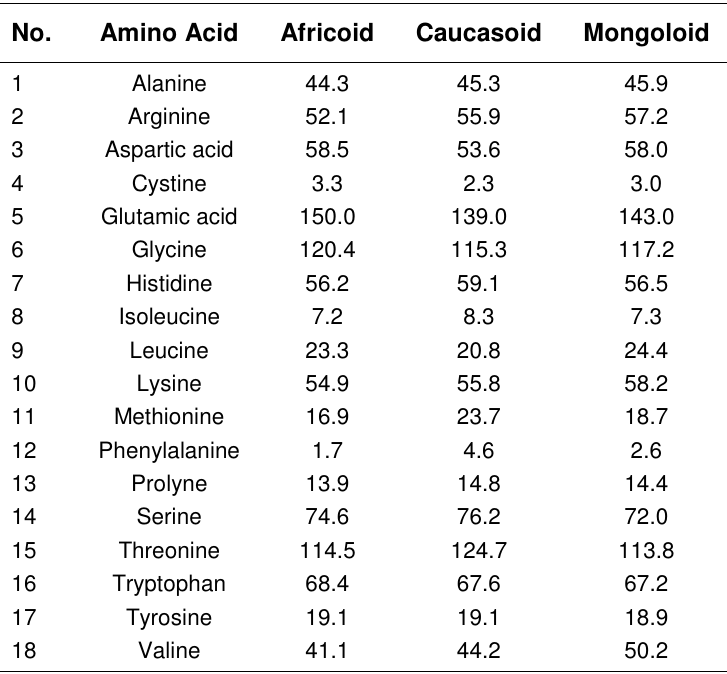
Amino Acid Content of Ethnic Hair Samples (µ M /g hair)